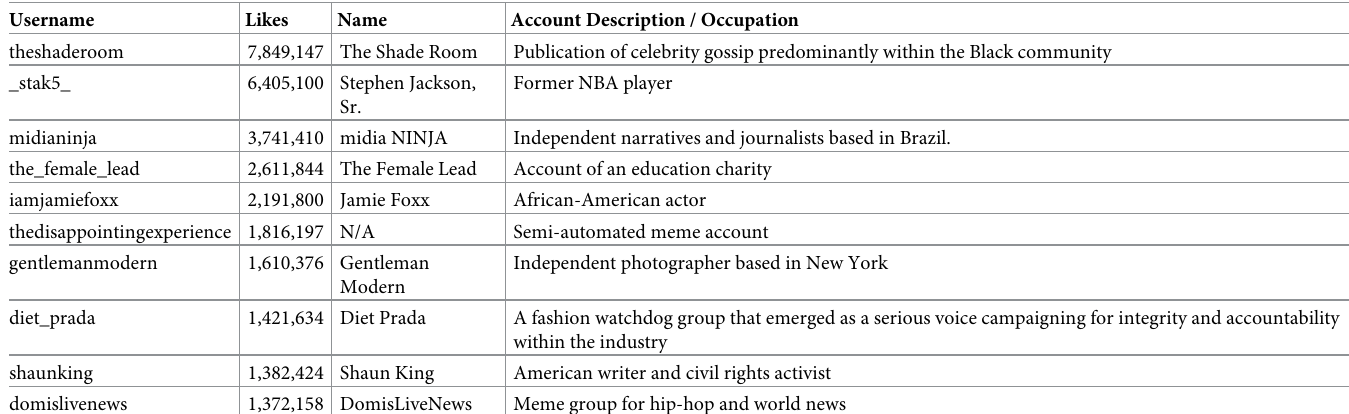
Table 4. Top 10 accounts by likes in the dataset. Opinion leaders include magazines and meme pages, in addition to institutional or established